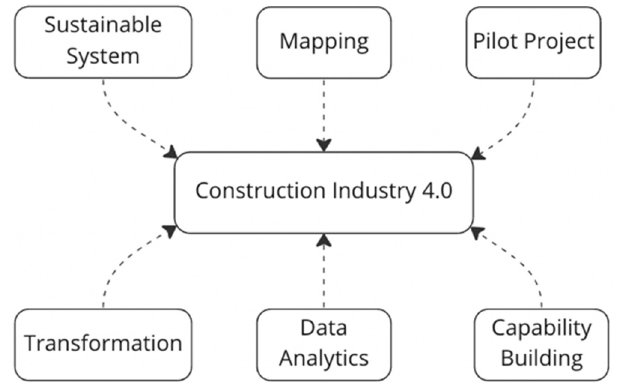
Figure 1. Implementation framework of Construction Industry 4.0.